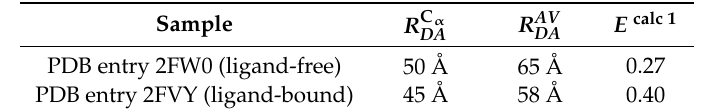
Table 1. smFRET parameters calculated on the basis of the MglB crystal structures from the ligand-free and ligand-bound state (see Figure